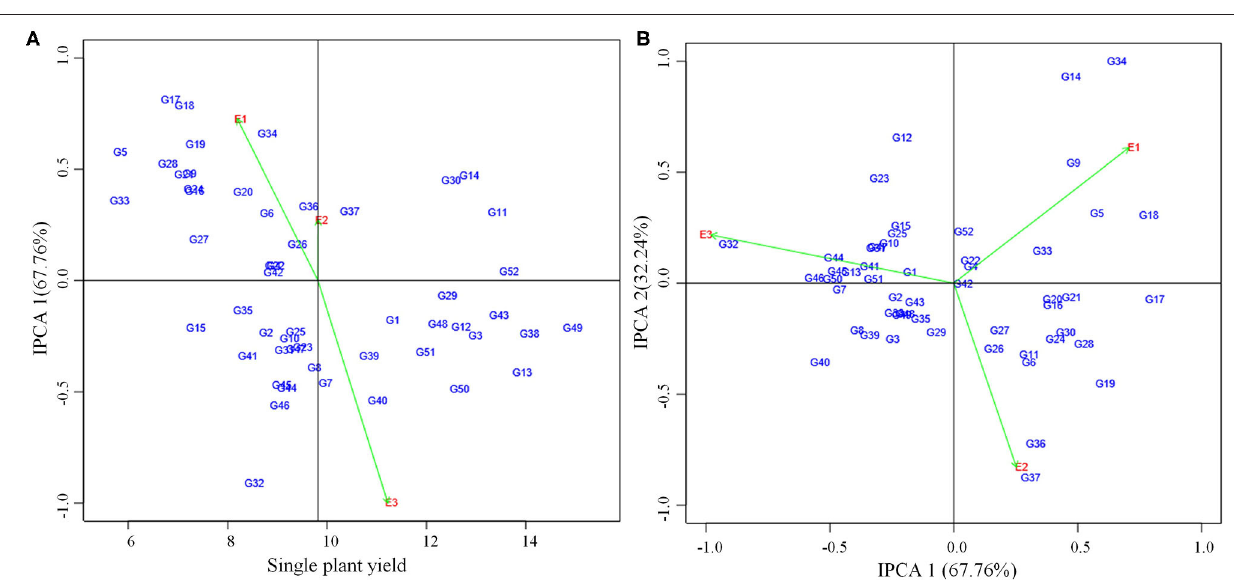
unstable ( Table 5 ). GSI integrates both yield and stability across environments. Genotypes with lower GSI (G52, G43, and G49) were desirable since they combine high mean yield performance check (CO 8) in E2 and E3. The genotype G49 outperformed both the checks (CO 8 and VBN 3) in E3 whereas outperformed the check CO 8 in